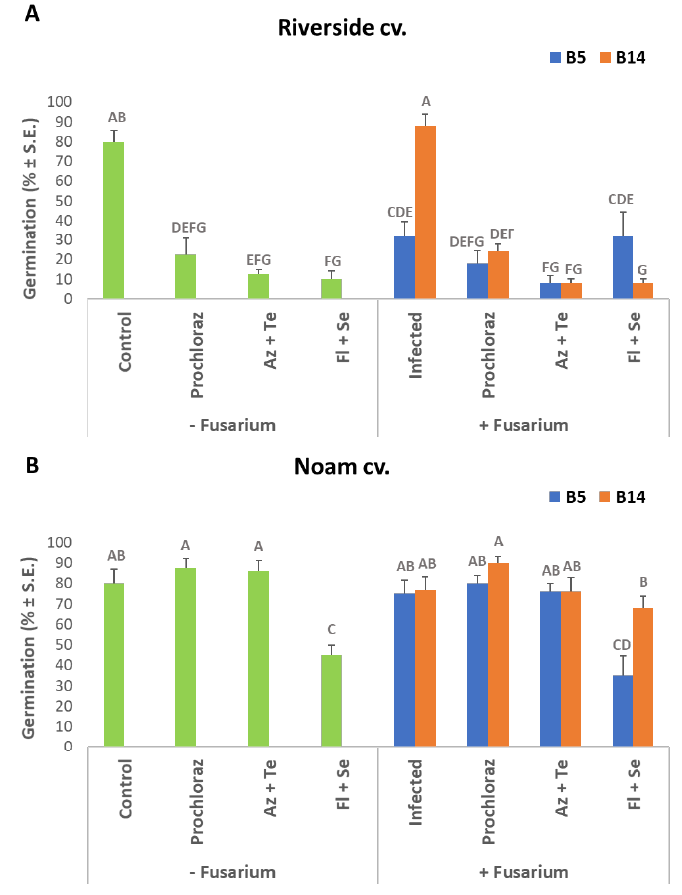
Figure 4. Percentage of Riverside cv. ( A , Orlando) and Noam cv. ( B ) onion seeds germinated under the influence of Fusarium spp., with or without fungicides seed coating. The pathogens Fusarium acutatum (isolate B5) and Fusarium oxysporum f. sp. cepae (isolate B14) were tested separately in this assay. Seeds were coated with Prochloraz (Sportak), Azoxystrobin + Tebuconazole (Az + Te, Azimut), and Fludioxonil + Sedaxen (Fl + Se, Vibrance) fungicides at concentrations of 0.3%, 33%, and 20% ( w / w ), respectively. The controls were uninfected seeds and pesticide-free treatments. Seeds were incubated in dark conditions at 28 ± 1 ˚C for nine days. The columns represent an average of five repetitions, deviation lines represent a standard error. Different letters above the columns represent a significant difference ( p < 0.05) in the ANOVA test.